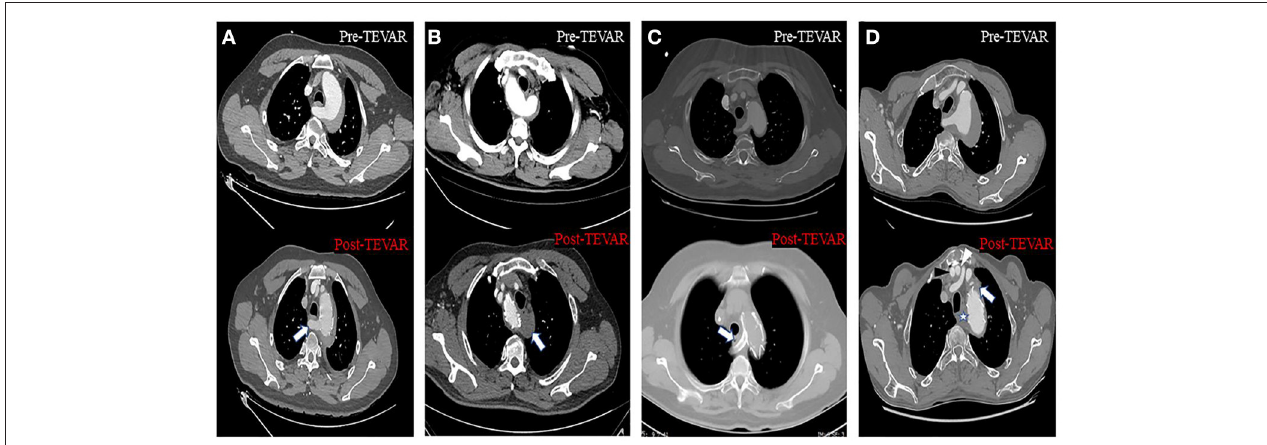
FIGURE 4 | Axial CT images about four different approaches to solve the inadequate proximal landing zone when TEVAR was performed. (A) Handmade fenestrated stent graft: arrow showed that the blood flow of the aberrant right subclavian artery (ARSA) was preserved. (B) Aberrant left subclavian artery (ALSA) was covered without non-revascularization, and arrow showed the thrombosis at the origin of the ALSA. (C) Chimney stent technology: arrow showed the ARSA was patent after the chimney stent was implanted. (D) Hybrid repair: black and white arrowhead showed the artificial blood vessel from aorta to right and left subclavian artery, respectively; star and arrow showed the thrombosis at the origin of the ARSA and left subclavian artery (LSA), respectively.